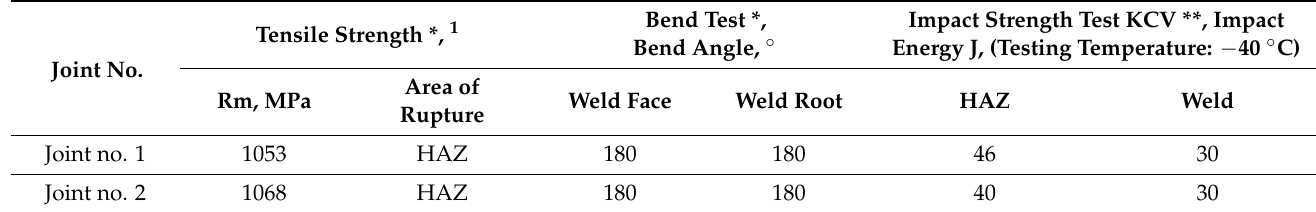
Table 4. Mechanical test results concerning the hybrid-welded joints made of steel S960QL.